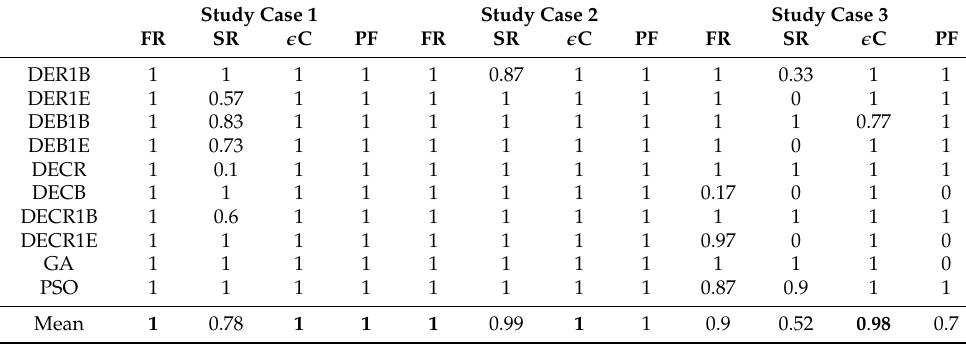
Table A12. FP metric values for each algorithm with the CHTs, and the related average values per CHTs for the three study cases.